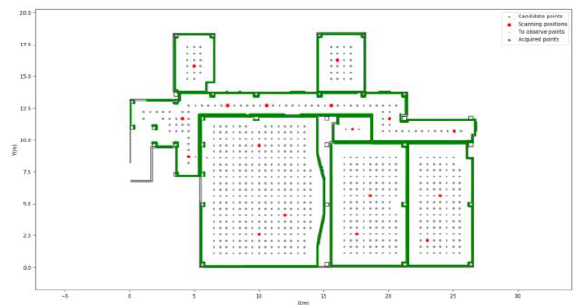
Figure 10. Cantidate positions (in grey), scanning positions (in red) and scanned points (in green) for the case study.